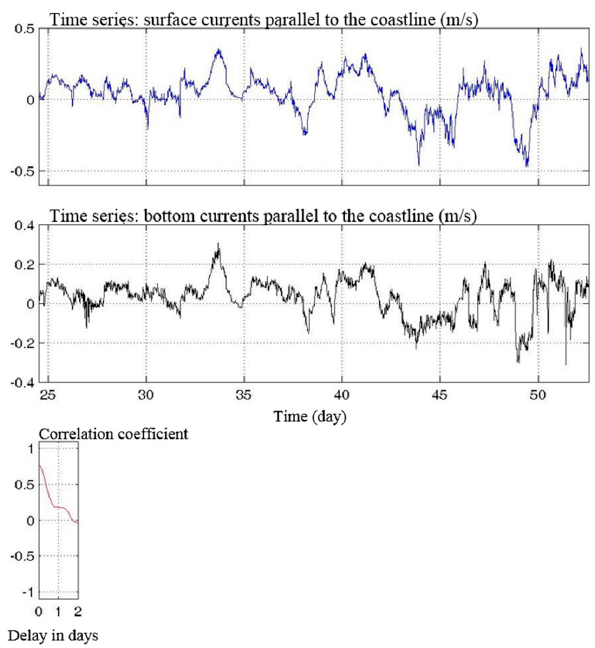
Figure 6. Correlation analysis between the surface and bottom currents, which shows a match, characteristic of a barotropic structure.